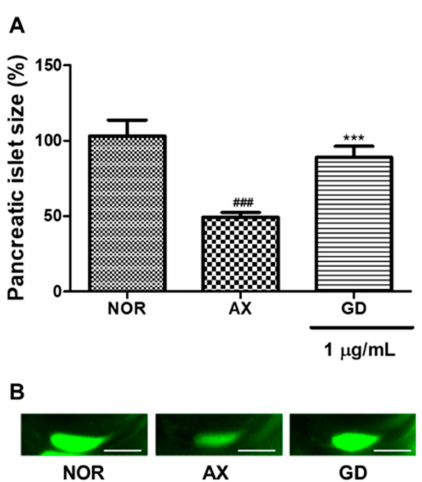
Figure 6. E ff ect of GD on alloxan-induced pancreatic islet-damaged zebrafish. ( A ) Pancreatic islet size of each group. ( B ) Pancreatic islet images. ( ### p < 0.001; compared to normal), (*** p < 0.001; compared to alloxan). Scale bar = 100 µ m.